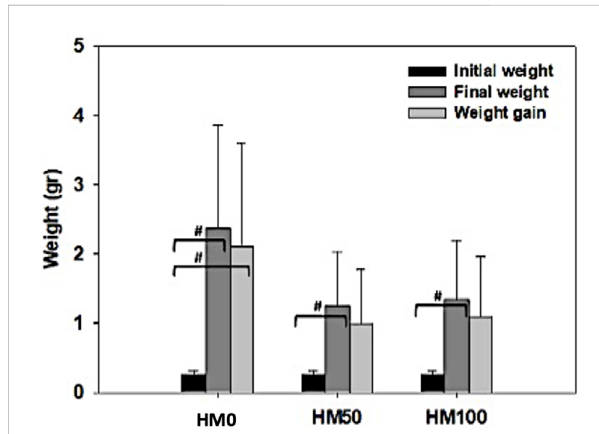
Initial, fi nal weight, and weight gain (mean ± stedv) between different dietary treatments (HM0, HM50 and HM100) in P. leptodactylus juveniles. Hashtag (#) depicts statistically signi fi cant differences ( p < 0.05) between fi nal weight or weight gain and initial weight. HM0 represents the control group while HM50 and HM100 the groups with 50% and 100% HM inclusion respectively.